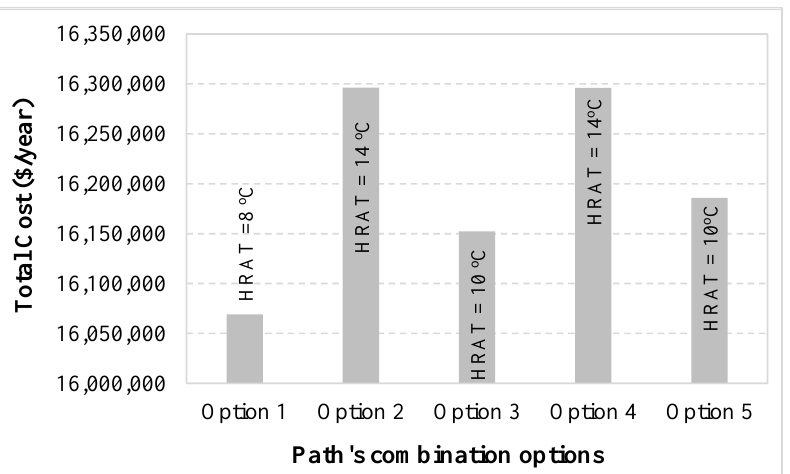
Figure 8. Comparison between total cost profile and optimum HRAT.